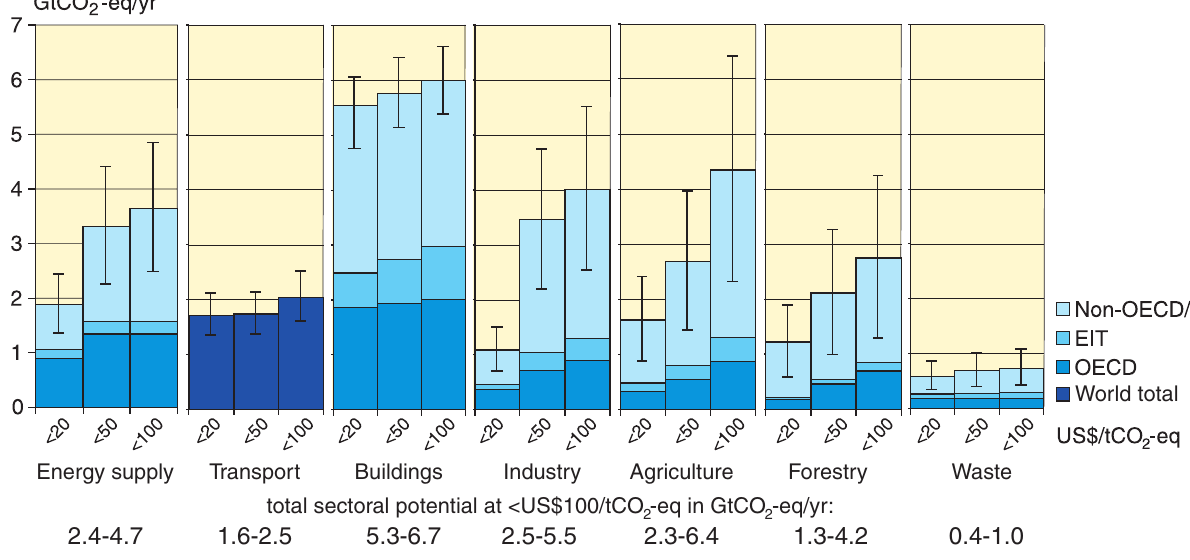
Figure SPM.10. Estimated economic mitigation potential by sector in 2030 from bottom-up studies, compared to the respective baselines assumed in the sector assessments. The potentials do not include non-technical options such as lifestyle changes. {Figure 4.2}